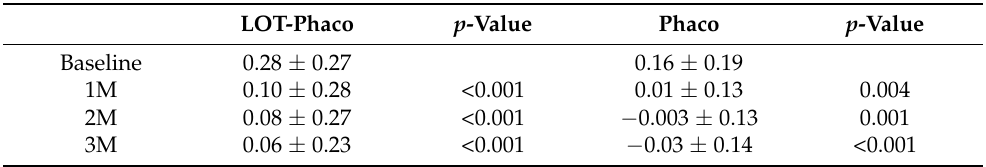
Figure 1. Mean intraocular pressure following Phaco-alone or LOT-Phaco. The intraocular pressure was significantly reduced in LOT-Phaco group compared with baseline. * p < 0.05 compared with baseline. Filled circle LOT-Phaco group; filled square Phaco group. Table 2. Postoperative logMAR visual acuity.